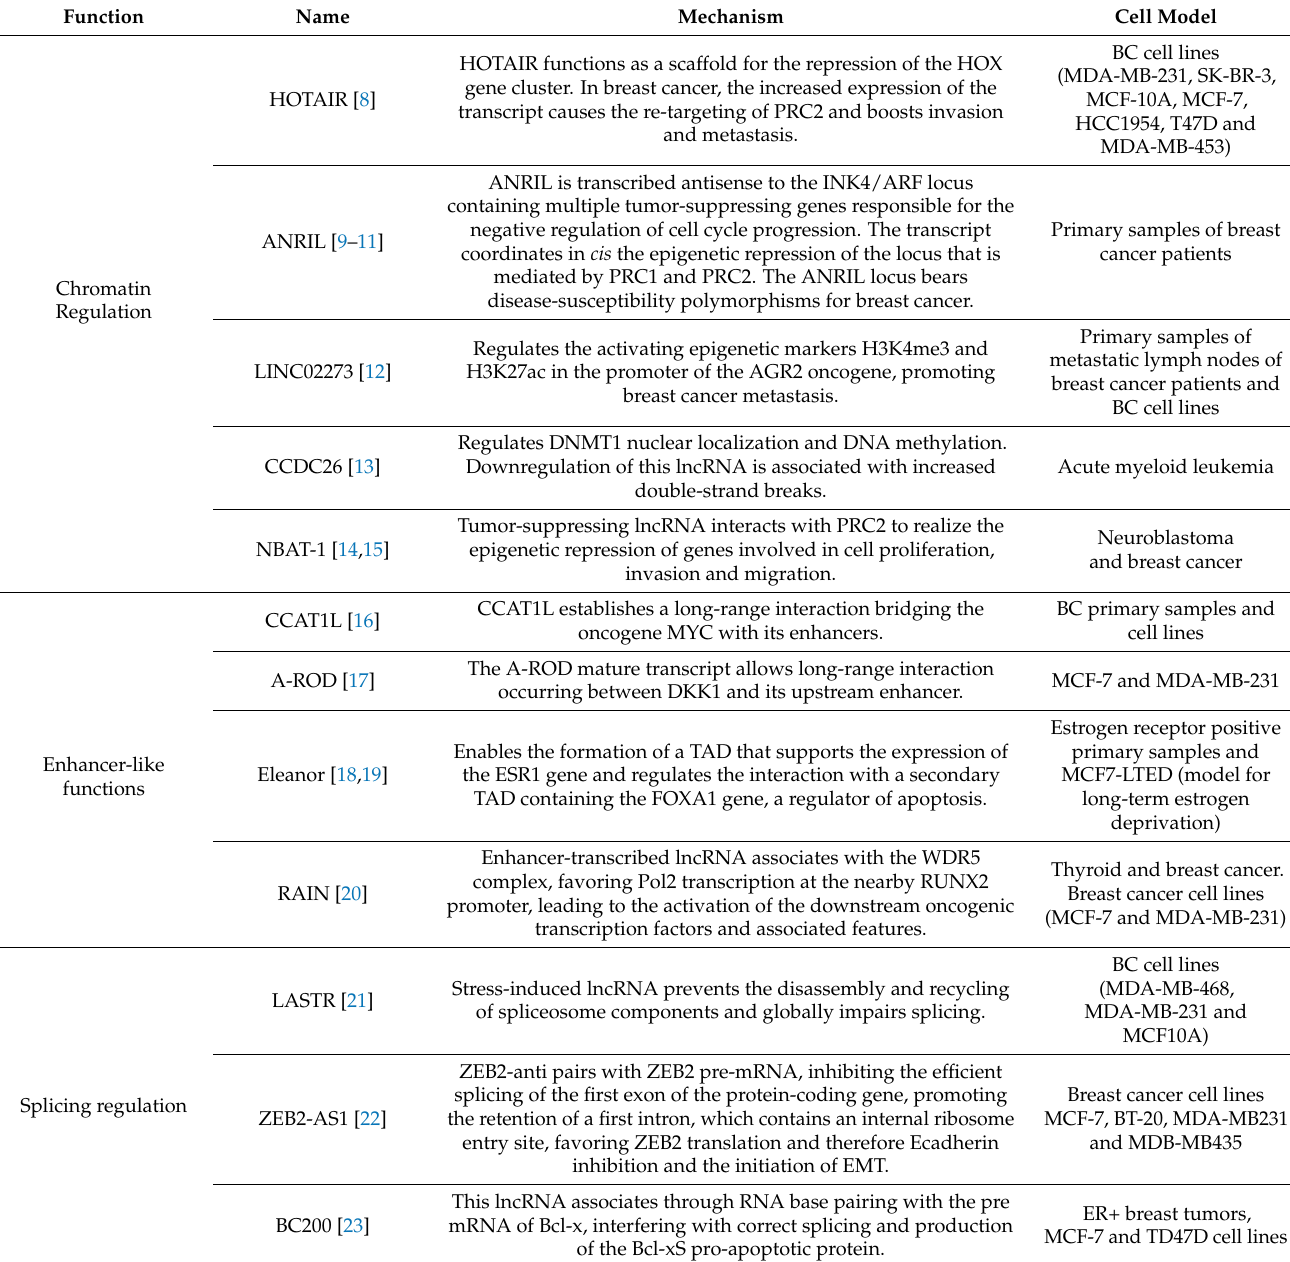
Table 1. Long non-coding RNAs and their